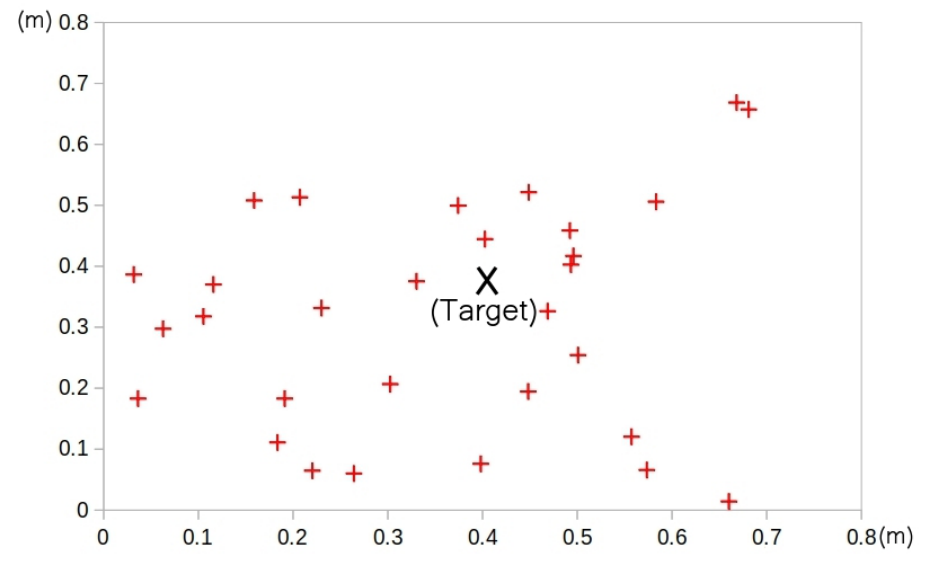
Figure 24. Landing error measurements for the 10-round landing